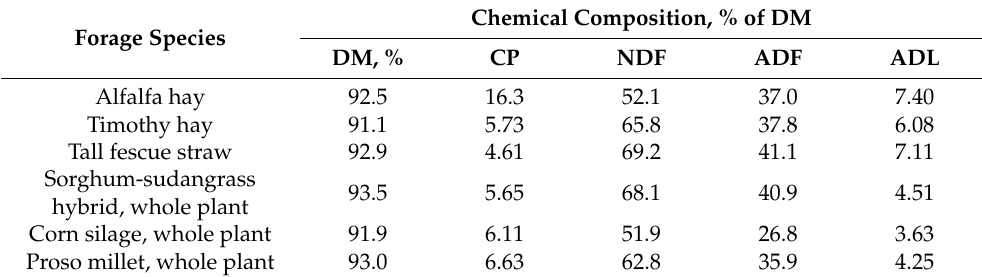
Table 1. Chemical composition of forage species used in experiment 1. Forage Species